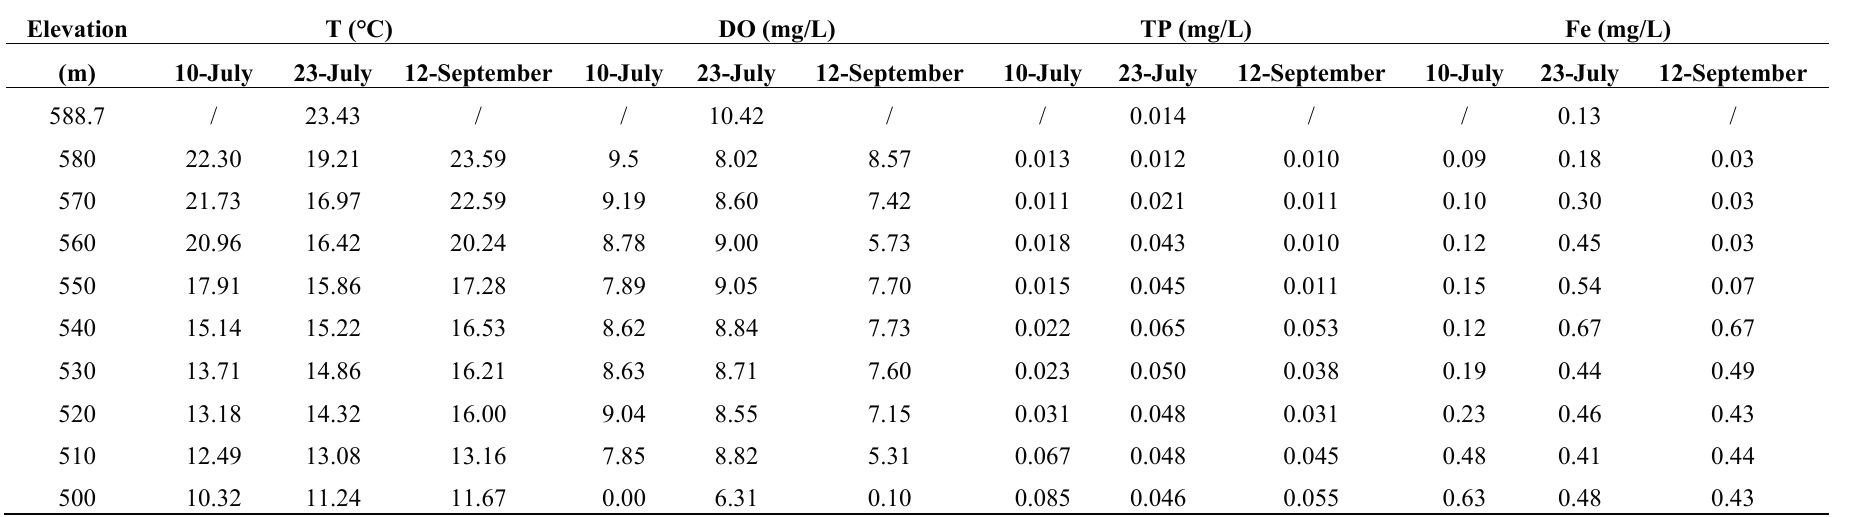
Table 1. Vertical distribution of temperature, DO, TP and Fe in the Heihe Reservoir at S1 in